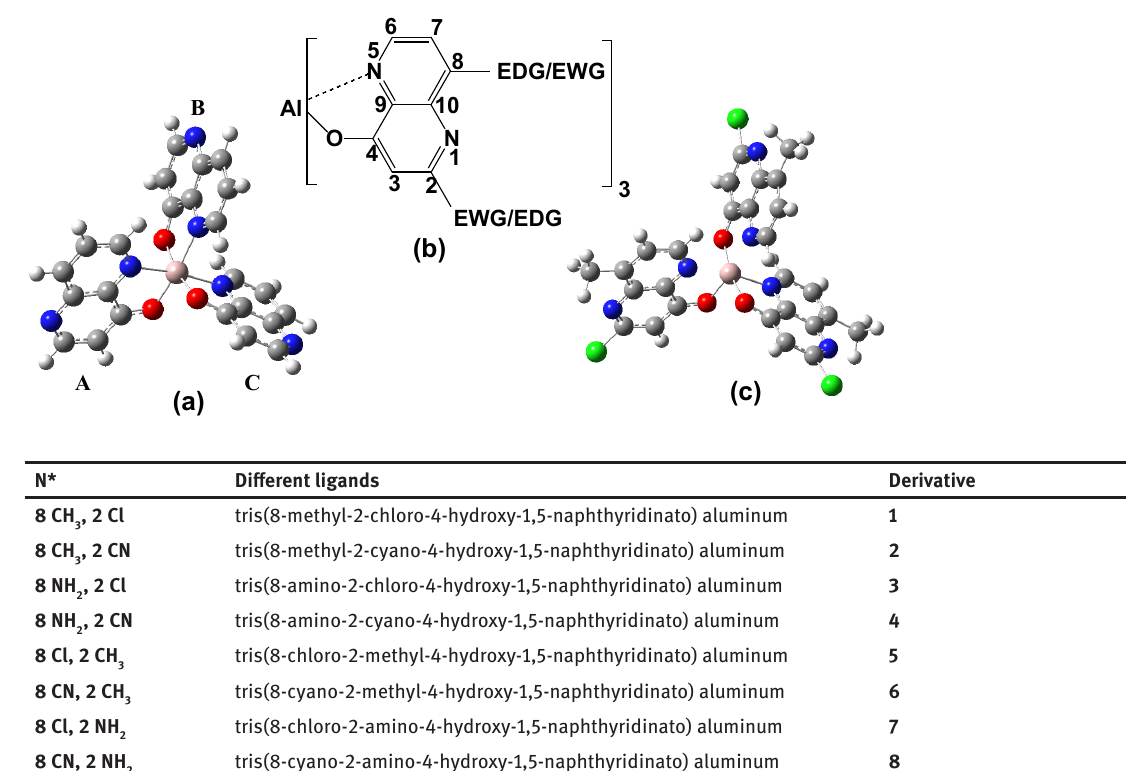
And EWG (-Cl or -CN) – (b). Figure 1: (a) The Geometry of mer -AlND3 with three ligands labeled as A-C (b) the atom numbering for the disubstituted mer -AlND3 complexes considered in this study (c) the structure of mer -tris(8-methyl-2-chloro-4-hydroxy-1,5-naphthyridinato) aluminumas an